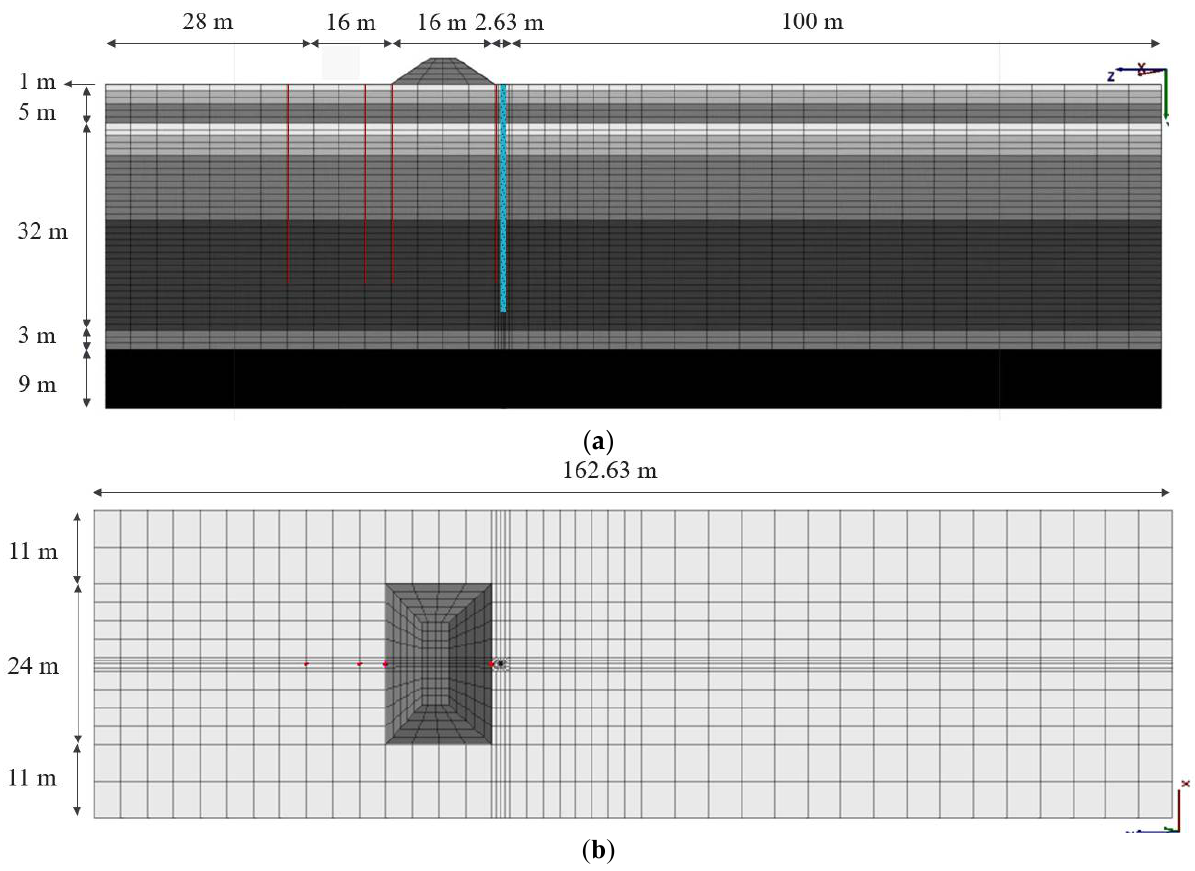
Figure 3. The mesh layout of the numerical model: ( a ) profile view; and ( b ) plan view.